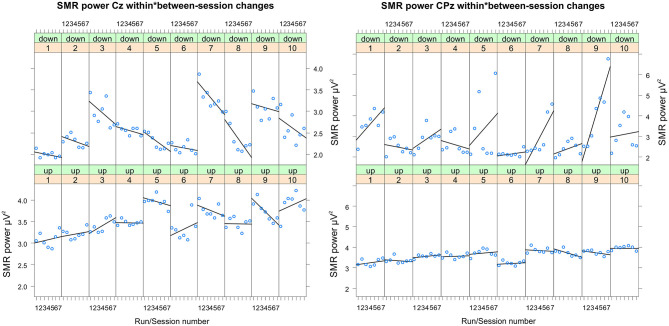
Changes in SMR power recorded over Cz and CPz per training session. Changes in SMR power over Cz (left panel) and CPz (right panel) across feedback runs (within-session changes, run 1 = baseline run, run 2 = 1st feedback run, run 7 = 6th feedback run), presented separately per neurofeedback training session (1–10) and group (down-regulation group: upper panel, up-regulation group: lower panel).